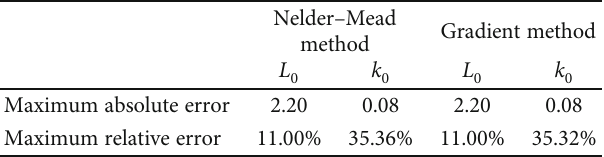
Table 5: Results of calculations with an error α = 20 %